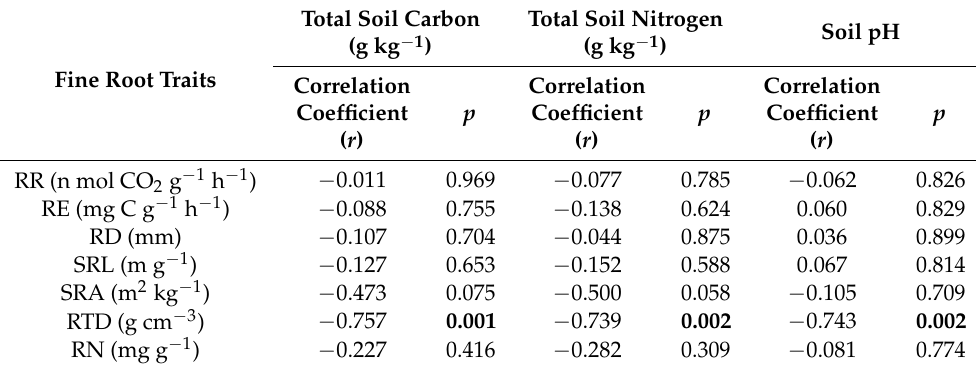
Table 4. Pearson’s correlations between root traits and the total soil carbon, total soil nitrogen and soil pH when data were pooled across all tree ages ( n =